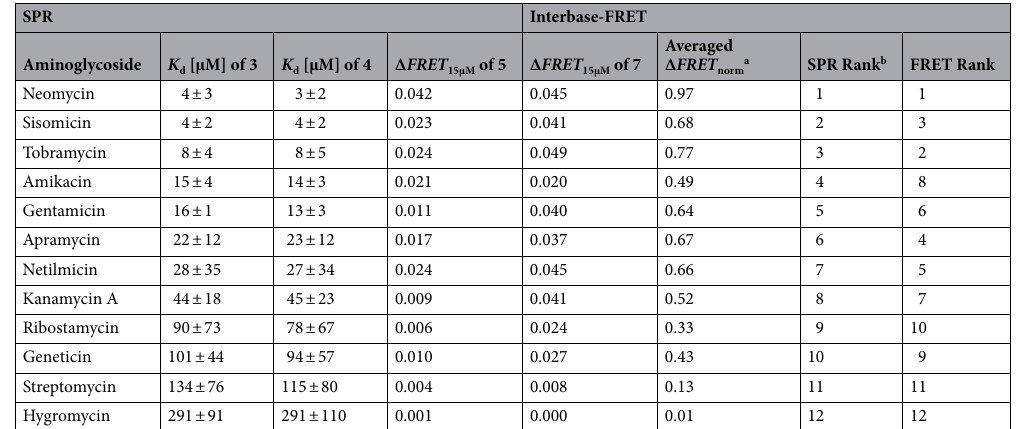
Table 2. SPR binding affinity for oligoribonucleotides 3 and 4 , interbase-FRET binding affinity for oligoribonucleotides 5 and 7 and the respective rankings of all aminoglycosides. a Averaged Δ FRET norm for the two FRET-labelled oligoribonucleotides ( 5 and 7 ) was calculated as an average of their Δ FRET norm values. The latter ones were obtained by dividing the Δ FRET from adding aminoglycoside to reach the total concentration of 15 µM to 1 µM oligoribonucleotide by the Δ FRET from adding aminoglycoside to reach 90% degree of complexation of the same oligoribonucleotide (Eq. 3, Tables S4-S5). b SPR rank was determined from the average dissociation constant of oligoribonucleotides 3 and